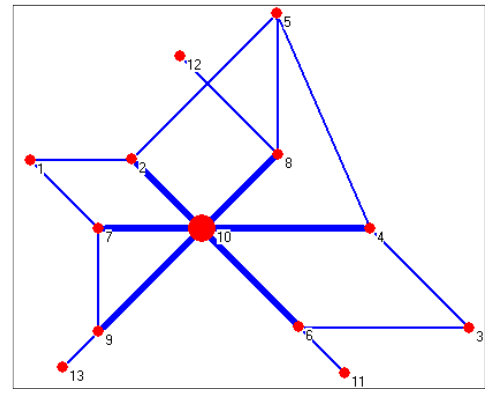
Figure 5. Data flow at the hub node.